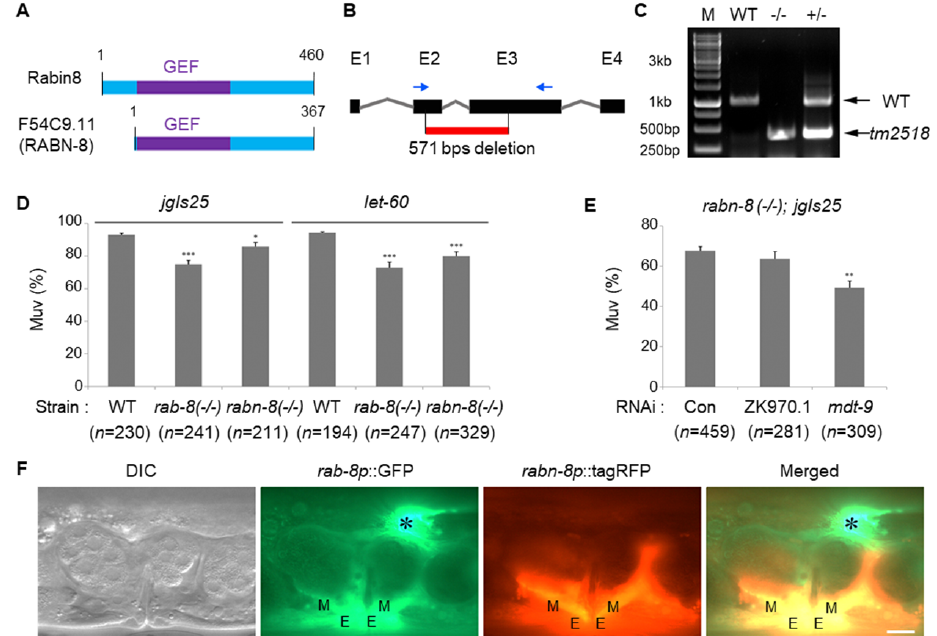
Figure 3. C. elegans Rabin8 ortholog RABN-8 functions in Muv formation. ( A ) Primary structure of human Rabin8 and C. elegans RABN-8 (F54C9.11) proteins. The conserved GEF domain and polypeptide length of each protein are indicated. ( B ) Genomic structure of rabn-8. The deletion site (red line) of the rabn-8 ( tm2518 ) mutant and 4 exons (E1 to E4) are shown. Blue arrows indicate primer sites used for genotyping. ( C ) Wild type (WT), tm2518 homozygote (-/-), and heterozygote (+/-) were genotyped by genomic DNA PCR using the primers indicated in B (blue arrows). M = size marker. ( D ) Muv strains ( jgIs25 and let-60 ) were crossed with rab-8 or rabn-8 mutants, and worms with Muv were counted. Error bar = SEM. (* p < 0.05 and *** p < 0.001 versus WT). ( E ) The rabn-8 ; jgIs25 strain was fed with RNAi of the MSS4 homologue ZK970.1 or mdt-9 and worms with Muv were counted. Error bar = SEM. (** p < 0.01 versus Con). These experiments were performed three times with comparable results. ( F ) Transgenic worms containing rab-8p ::GFP and rabn-8p ::tagRFP expression plasmids were observed. Asterisk = distal tip cell. M = vulval muscle. E = vulval epithelia. Scale bar = 10 µ